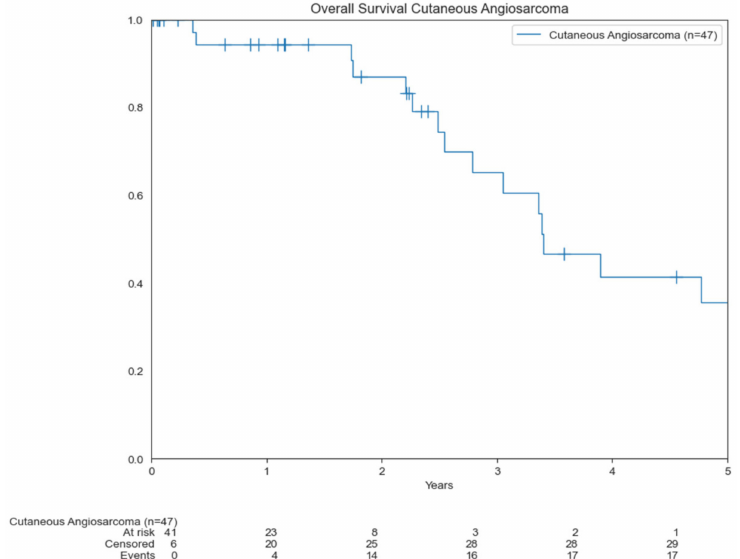
Figure 2. Kaplan–Meier curve showing OS for patients. Patients who underwent surgical resection had a statistically significant increase in OS compared to those who did not undergo surgery (5.4 vs. 2.8 years) ( p = 0.0193) (Figure 3A). There was not a significant difference in OS for patients who had RT ( p = 0.0696) and chemotherapy ( p = 0.143) compared to those who did not undergo these treatment modalities. Median OS for those who underwent RT was 3.9 years compared to 2.5 years for those who did not. Median OS for those who underwent chemotherapy was 3.3 years compared to 7.2 years for those who did not (Figure 3B,C). About 45% of patients were found to have positive margins. Median OS of patients who underwent surgery